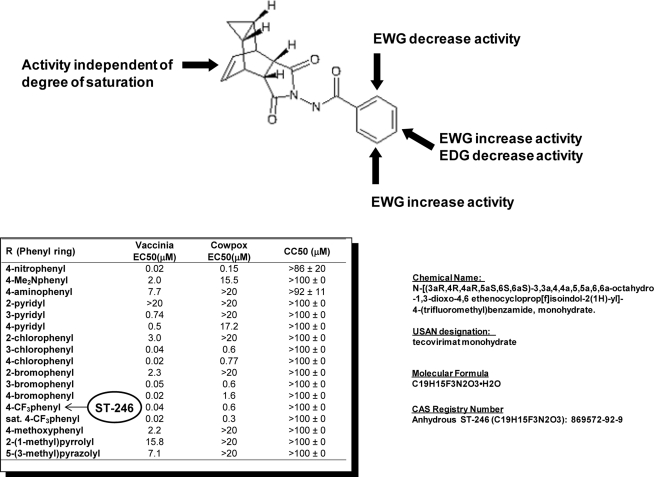
Structure activity relationships and chemical information for ST-246. A summary of antiviral activity of chemical analogs of ST-246 (adapted from Bailey et al. [18]). EWG—Electron withdrawing groups; EDG—Electron donating groups. R refers to modifications of the phenyl ring.